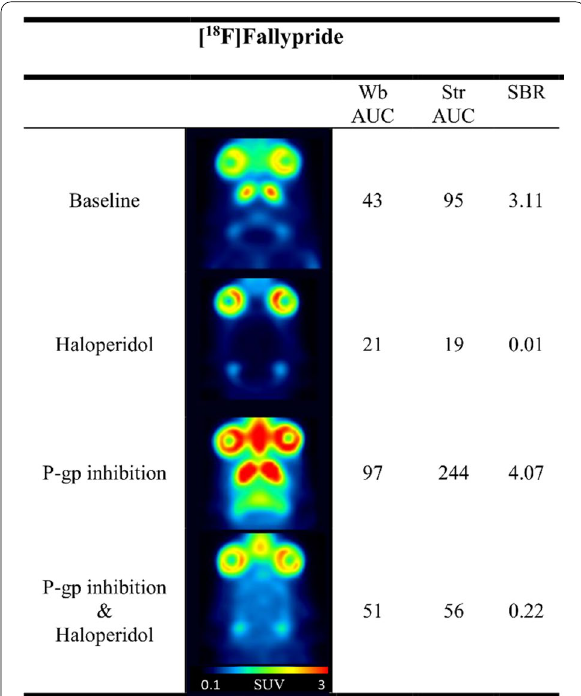
Fig. 4 PET images, AUC and SBR values for the D 2/3 receptor tracer [ 18 F]Fallypride. Representative horizontal rat PET images, 60-min AUC values (min g/mL) and SBR values are shown for baseline, target × block with haloperidol, P-gp inhibition with elacridar and combined P-gp inhibition—target block conditions (see Table 1 for details on drug dosing and PET image summation, n 2). Str striatum, Cb = cerebellum, Wb whole brain, AUC area under the curve, SBR specific binding ratios, P-gp